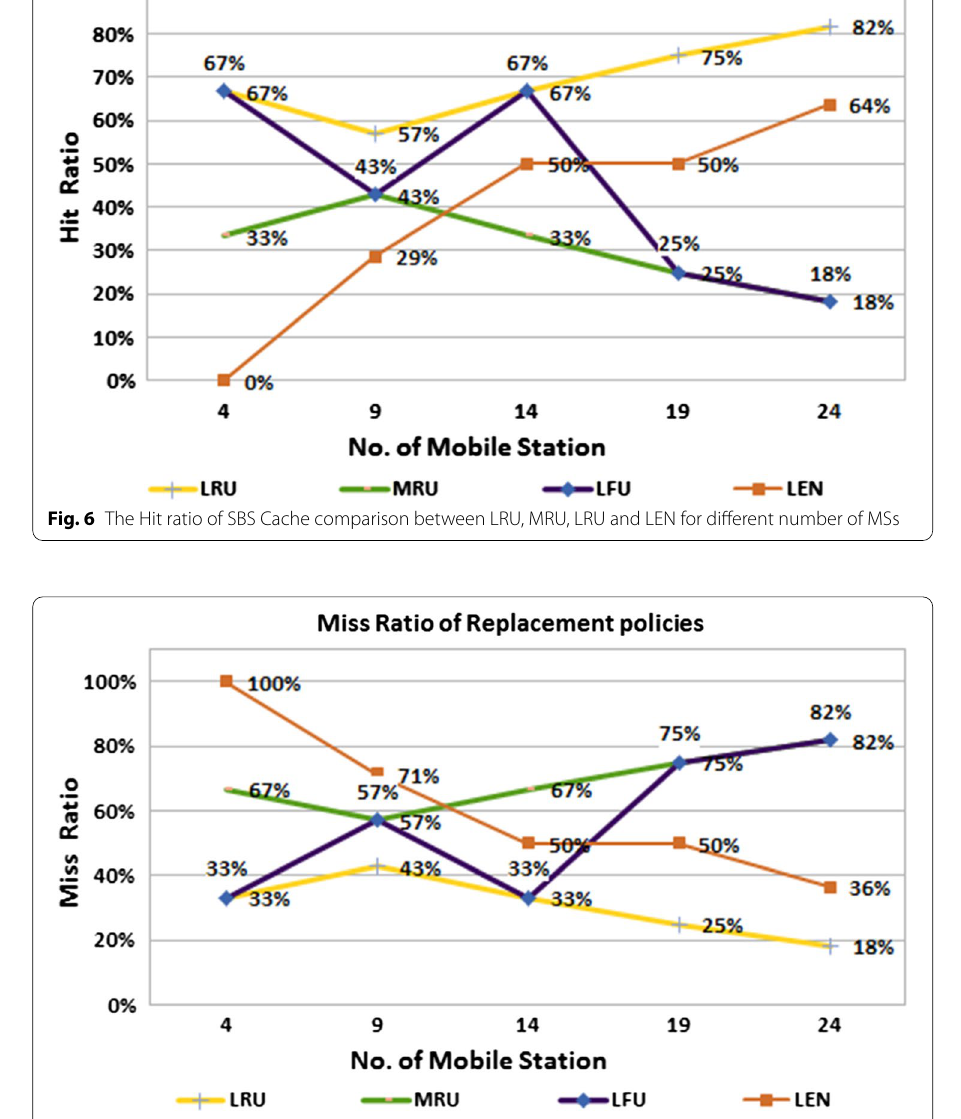
Fig. 7 Miss ratio of SBS cache comparison between LRU, MRU, LRU and LEN for different number of